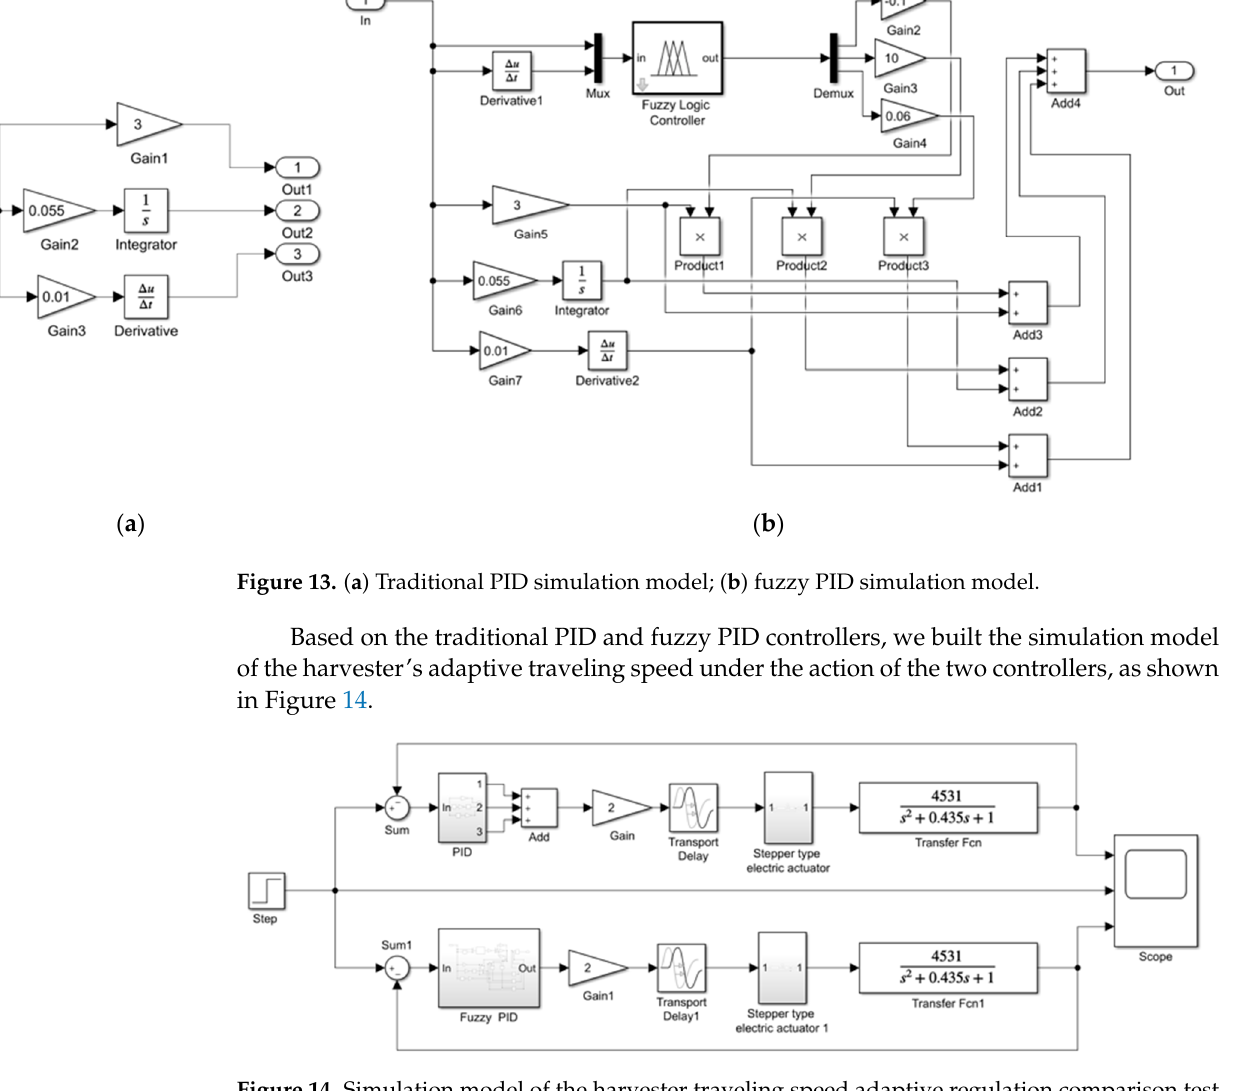
Figure 14. Simulation model of the harvester traveling speed adaptive regulation comparison test system.